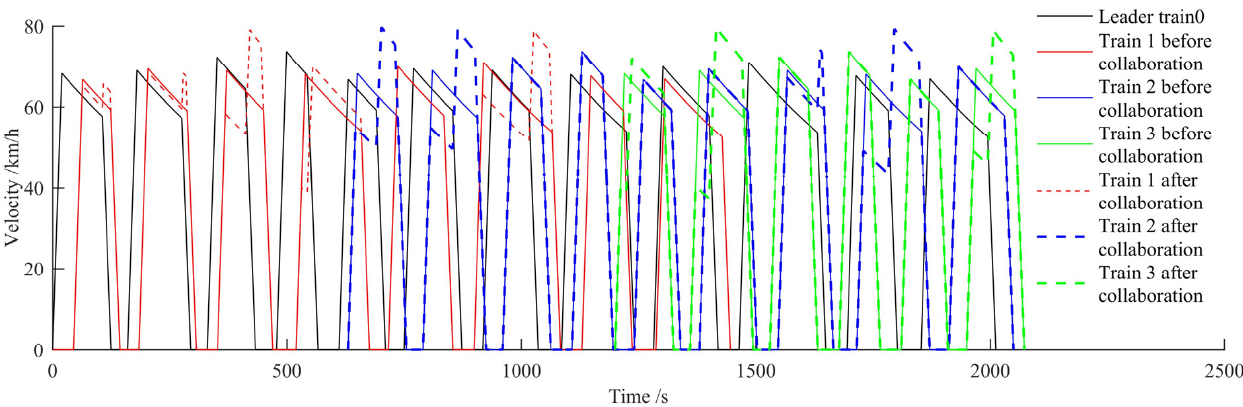
Figure 4. Velocity–time curve of trains after optimization .